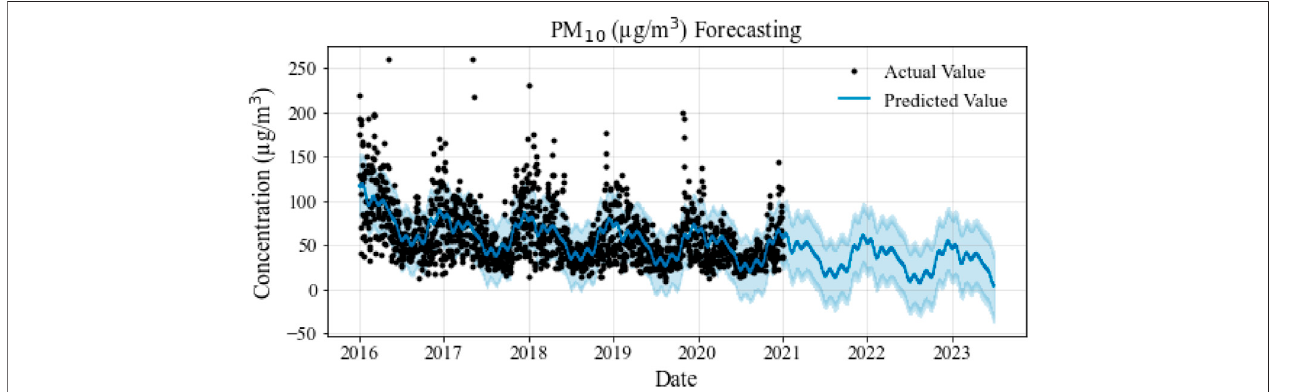
FIGURE 3 | PM 10 (µg/m 3 ) forecasting in jiangsu province.